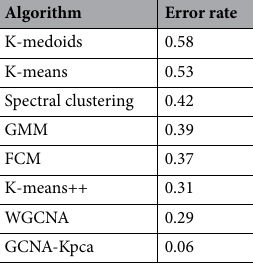
Table 1. Comparison of error rates among the eight algorithms (K-means, K-means++, K-medoids, GMM, Spectral Clustering, FCM, WGCNA and GCNA-Kpca).